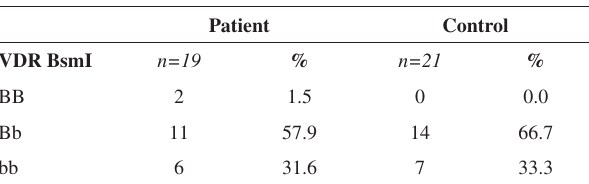
Table 3 - Distribution of VDR gene BsmI polymorphism